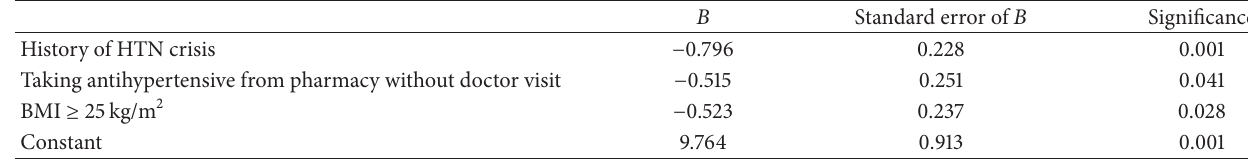
Table 4: Linear regression analysis of variables associated with the MMAS-8